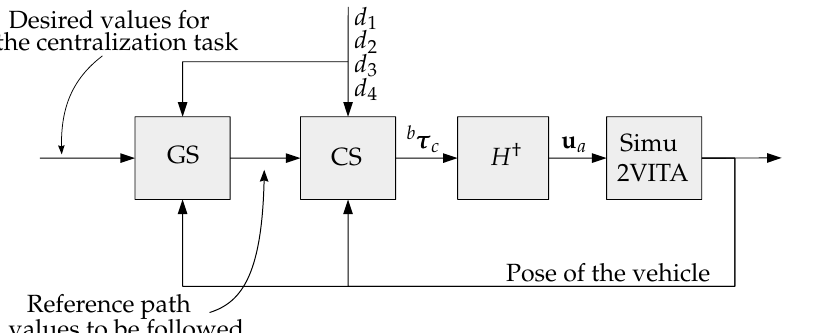
Figure 13. Diagram of the connection of the Guidance System (GS), Control System (CS) and